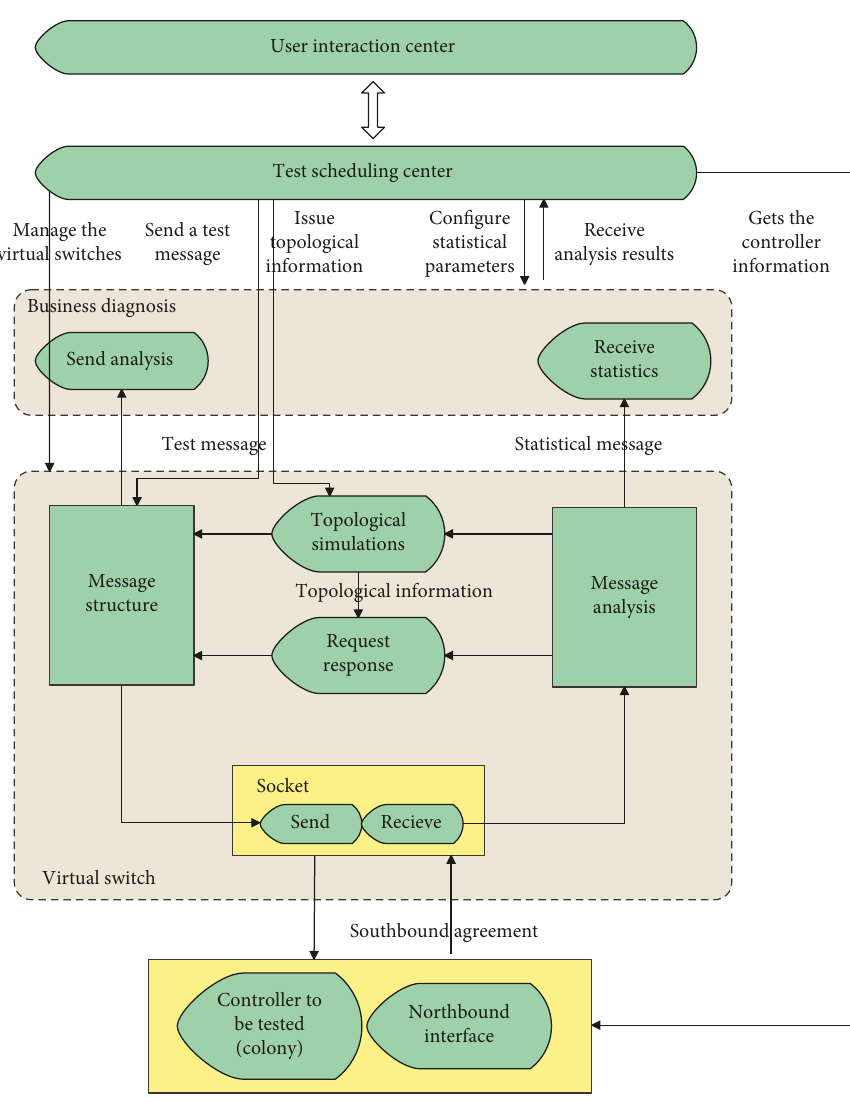
Figure 7: Frame diagram of the controller performance test